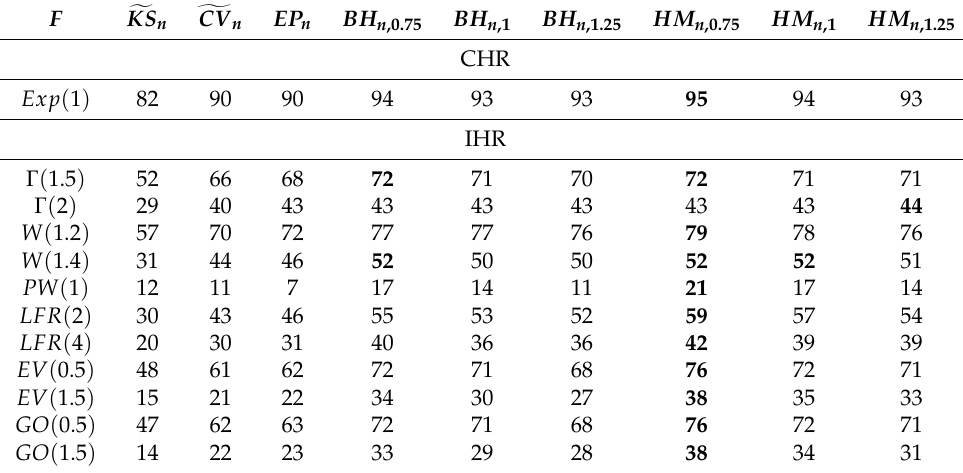
Table 6. Estimated powers for general alternatives for the exponential distribution for sample size n =